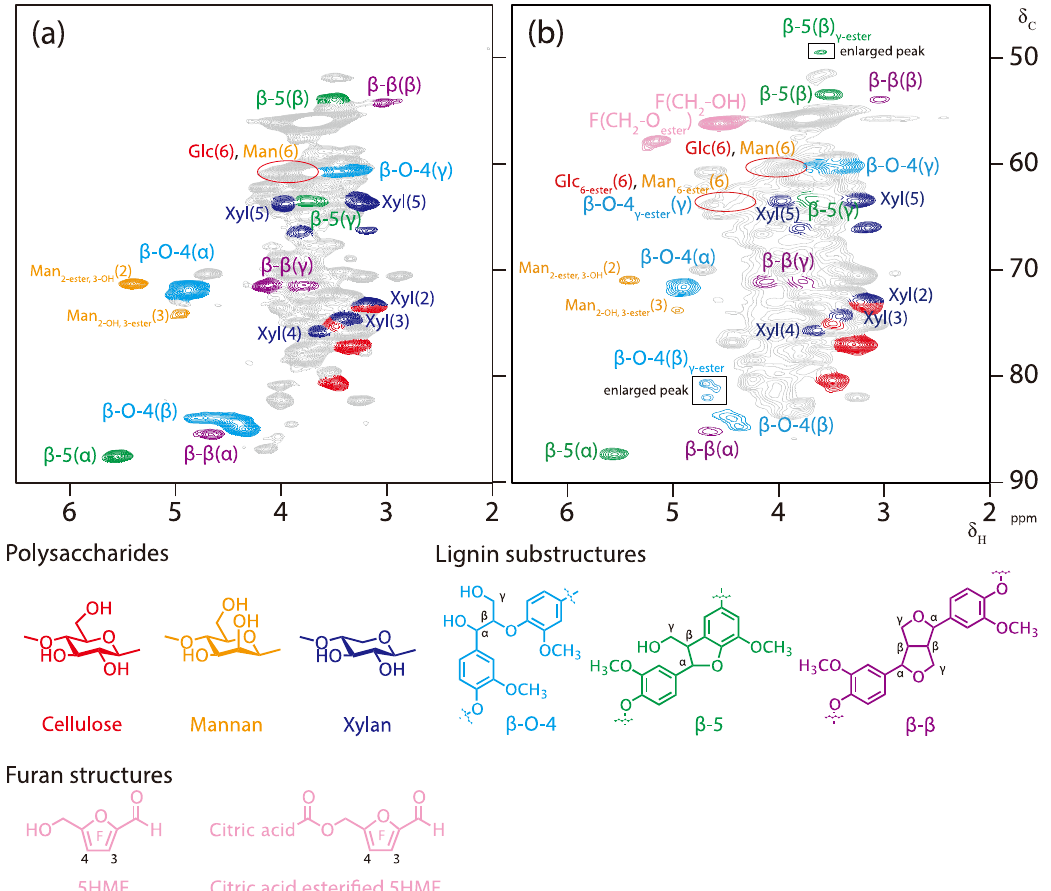
Figure 1. HSQC-NMR spectra in the aliphatic region of wood (Japanese cedar) ( a ) and the sucrose/citric acid type adhesive wood-based molding (W80) ( b ).